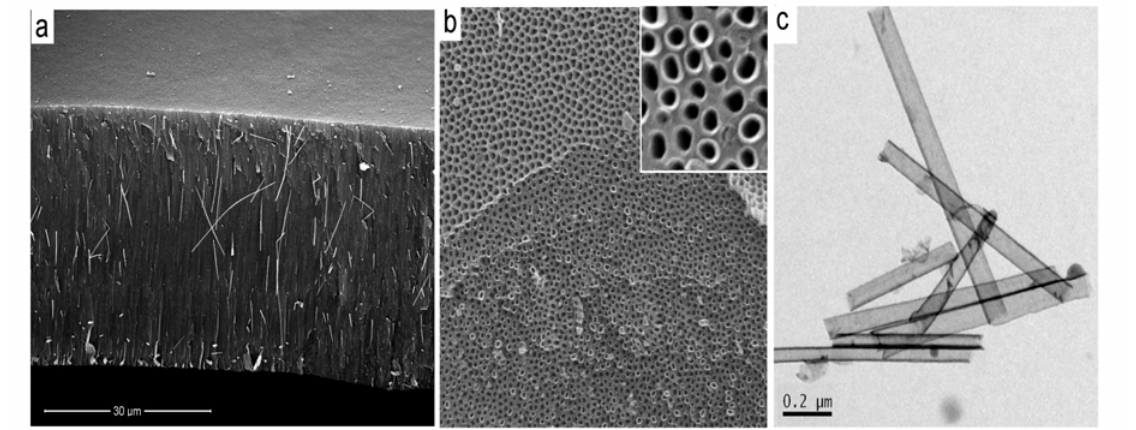
Figure 5. CNT/PA membranes prepared by catalyst free carbon precursor (toluene/ethanol). (a) cross-sectional SEM image of whole membrane; (b) Image from the top surface showing that the growth of the CNT is terminated on the top without of overgrowth; and (c) TEM image of liberated CNT grown inside of